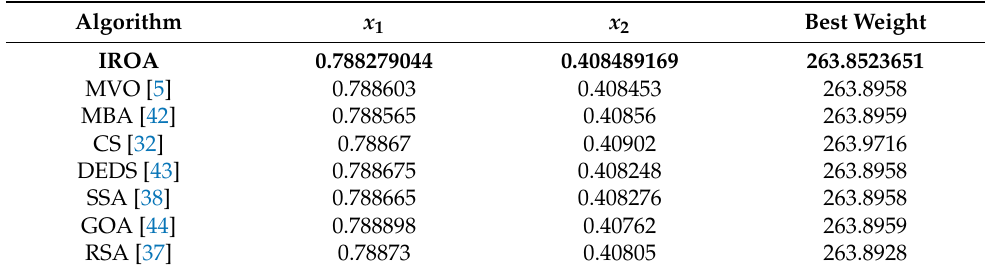
Table 12. Experimental results of three-bar truss design.